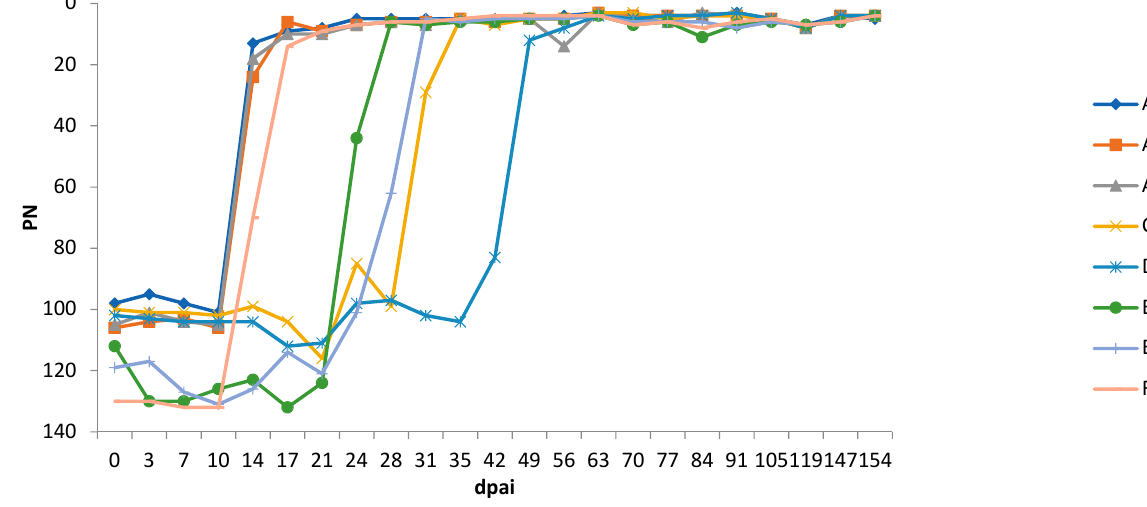
Figure 2. The level of antibodies in blood of heifers infected with BTV-8 contaminated semen from natural-infected bulls, as determined by a competitive ELISA and expressed in percentage negativity (PN). dpai: days post artificial insemination.